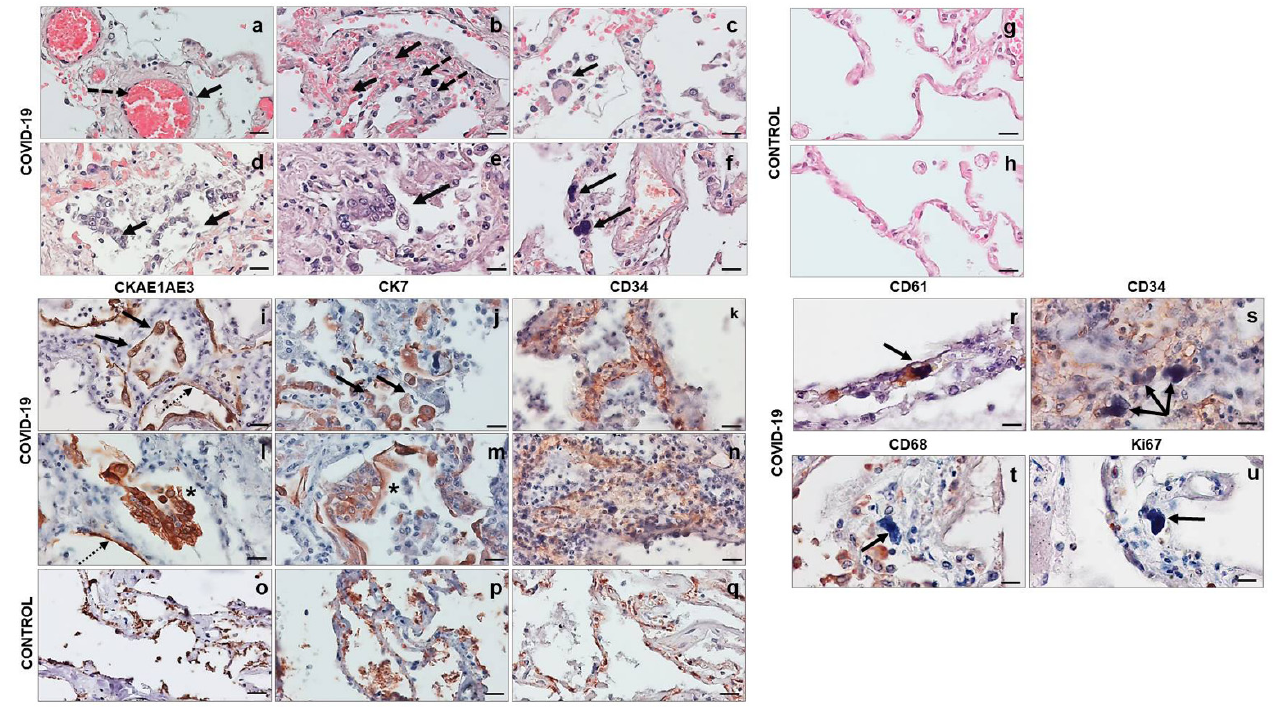
Figure 1. Histological staining of the lung parenchyma. ( a – h ) Hematoxylin and eosin staining of COVID-19 and control lungs. The parenchyma showed marked congestion with microthrombi of the small vessels (( a ), arrow) and edema (( a , b ), dotted arrows). There was visible hemorrhage in the interstitium and alveolar space (( b ), arrows), in which histiocytes and inflammatory cells (( c ), arrow) and desquamated hyperplastic pneumocytes (( d ), arrows) were found. Aggregates of type II pneumocytes (( e ), arrow) and cells with large, irregular, and monstrous nuclei (( f ), arrows) were evident. The control parenchyma showed a normal appearance with intact alveolar wall and empty alveolar space ( g , h ). ( i – q ) Representative images of immunohistochemical reactions in COVID-19 and control lungs. ( i , j ) Hyperplasia of type II pneumocytes stained with CKAE1AE3 (( i ), arrows) and CK7 (( j ), arrows). ( l , m ) Aggregates of type II pneumocytes, positive to CKAE1AE (( l ), showed with an asterisk in the figure) and CK7 (( m ), asterisk). The dotted arrows indicate the hyaline membranes originating from the destruction of the epithelial lining and stained with CKAE1AE3 ( i , l ). ( k , n ) CD34 showed vascular congestion and increased microvascular texture. Normal microvascular architecture was present in control lung ( q ). ( a – q ) Magnification 400×, scale bar 20 µm. ( r – u ) Representative images of immunohistochemical reactions in COVID-19 lung. The cells with abnormal nuclei were positive to CD61 (( r ), arrow); they were located inside the blood vessels (( s ), arrows) and were negative for CD68 (( t ), arrow) and Ki67 (( u ), arrow). ( r – u ) Magnification 630×, scale bar 20 µm.